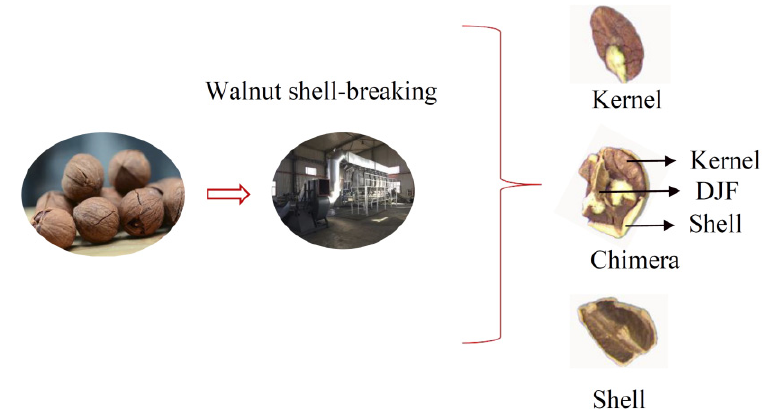
Figure 1. The phenomenon of misclassification after walnut shell–kernel separation .